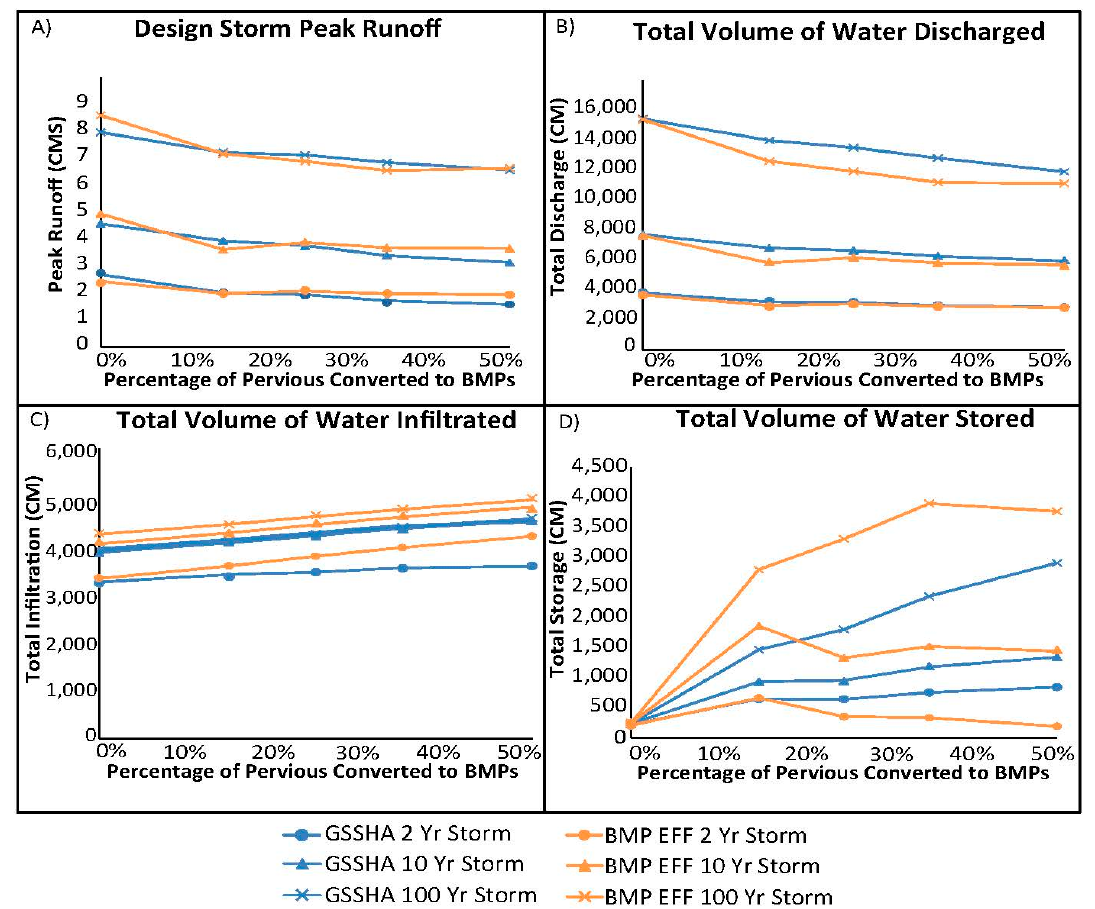
Figure 7. Green Infrastructure comparison results with the BMP Effectiveness Ratios applied in SWMM. GSSHA results are presented in blue, and SWMM with BMP Effectiveness ratios are presented in orange for each simulation and storm event. The results are presented for: Peak Runoff ( A ); Runoff Volume ( B ); Total Infiltration Volume ( C ); and Total Storage ( D ). The results indicate that application of BMP Effective ratios in SWMM produced results that are consistent with GSSHA.